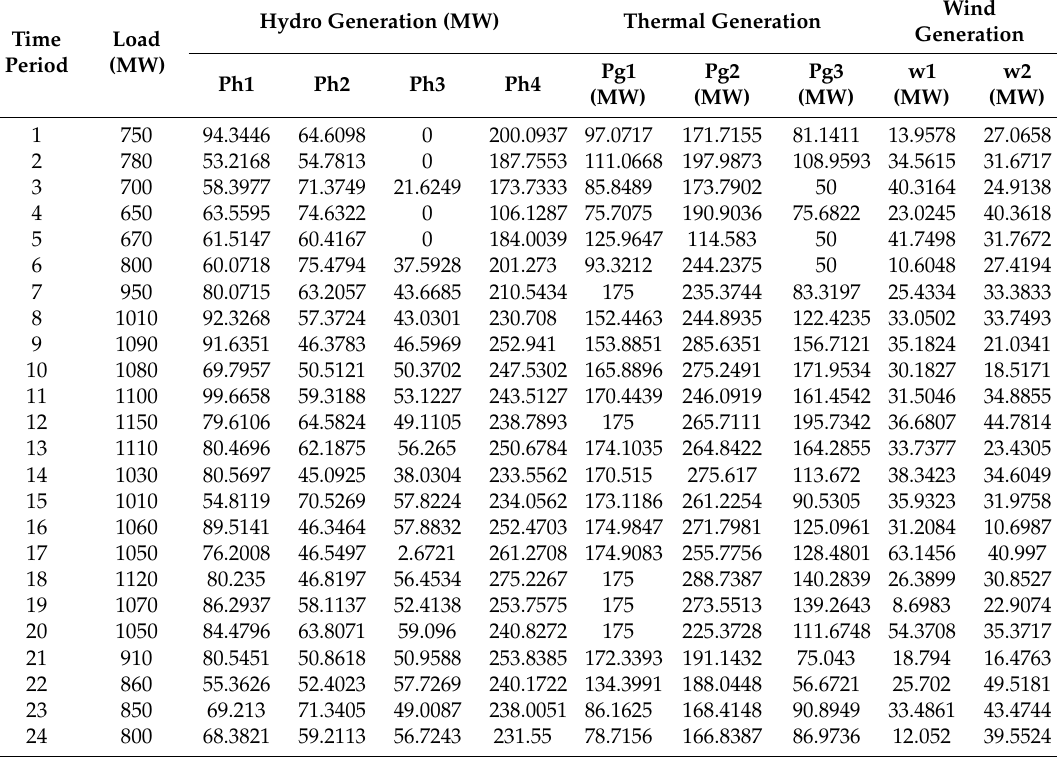
Table 1. Optimal generation schedule of the hydro ‐ thermal ‐ wind system obtained using the MPSO method.